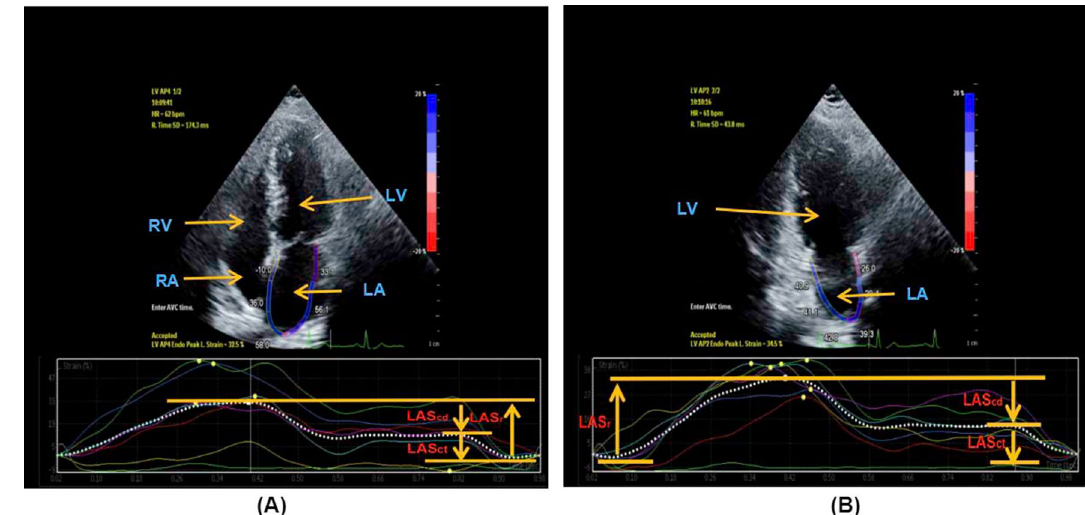
Figure 1. 2D-STI parameters of left atrium in control group. 2D-STI parameters of left atrium obtained from apical four-chamber view in control group ( A ). 2D-STI parameters of left atrium obtained from apical two- chamber view in control group ( B ). LAGLS left atrial global longitudinal strain, LASr left atrial strain during reservoir phase, LAScd left atrial strain during conduit phase, LASct left atrial strain during contraction phase, LV left ventricle, LA left atrium, RV right ventricle, RA right atrium.